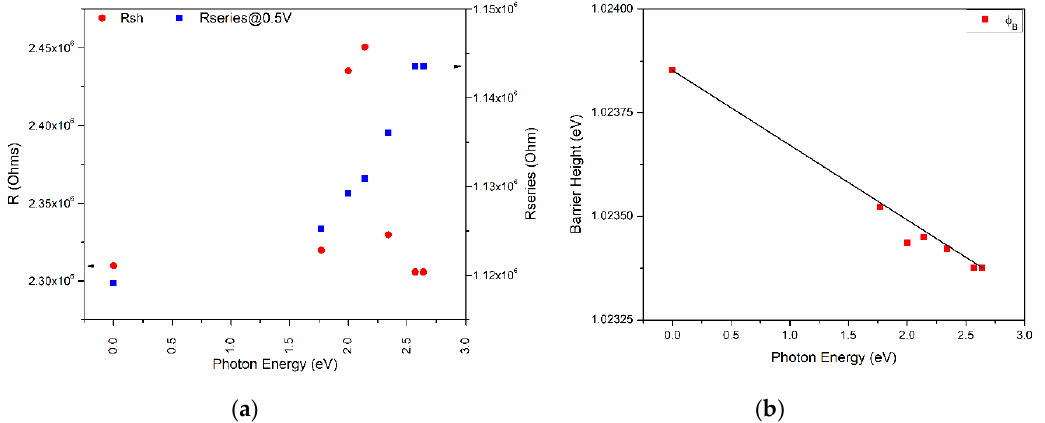
Figure 9. ( a ) Series and shunt resistance, threshold voltage, and ( b ) barrier height against illumination photon energy for device 1.